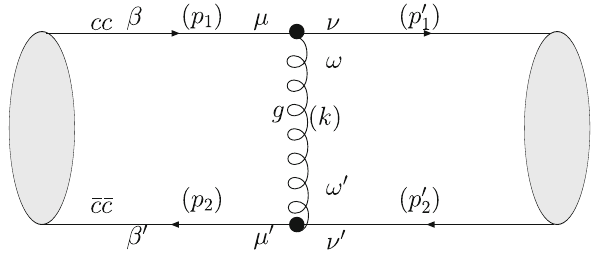
Fig. 1 The tetraquark state of cc and ¯ c ¯